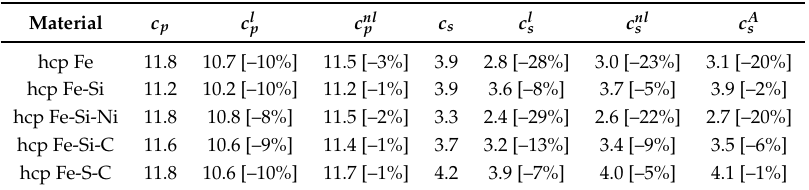
Table 3. Comparison of seismic wave speeds obtained from v D for iron alloys at inner core conditions (Table 1). The material’s true compressional wave speed ( c p ; column 2) is compared against those obtained using linearized form of Equation (21) ( c l p ; column 3) and solving the full non-linear equations ( c nl p ; column 4). Columns 5 through 7 are the same as columns 2 through 4 except for shear